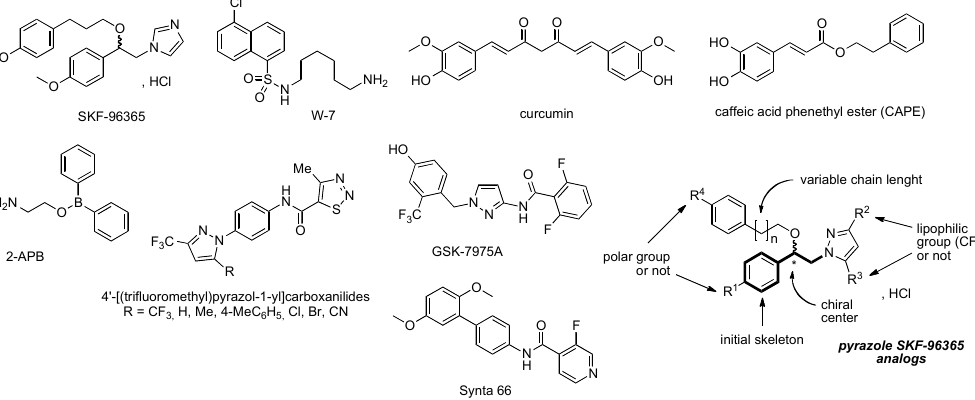
Figure 1. Structure of pharmacological inhibitors of calcium channels and structure–activity relationship (SAR) parameters of the pyrazole SKF-96365 analogues.